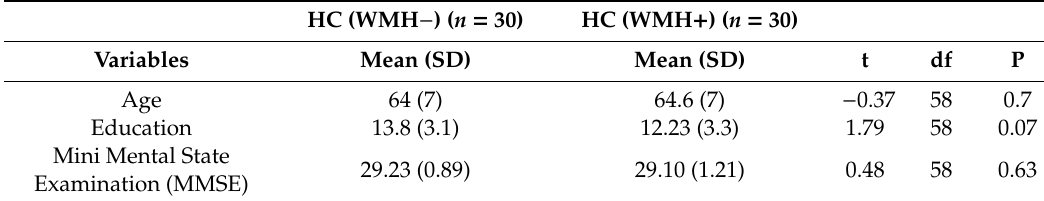
Table 1. Demographic and cognitive characteristics of the 60 healthy